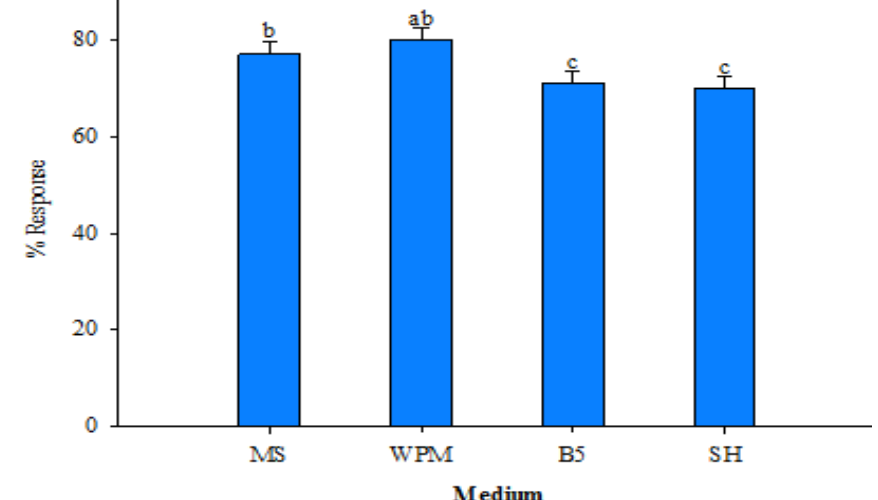
Figure 2. Effect of different medium supplemented with 5.0 µM BA and 1.0 µM NAA on the conversion of encapsulated nodal segments of R. serpentina after 4 weeks of storage at 4 °C a .